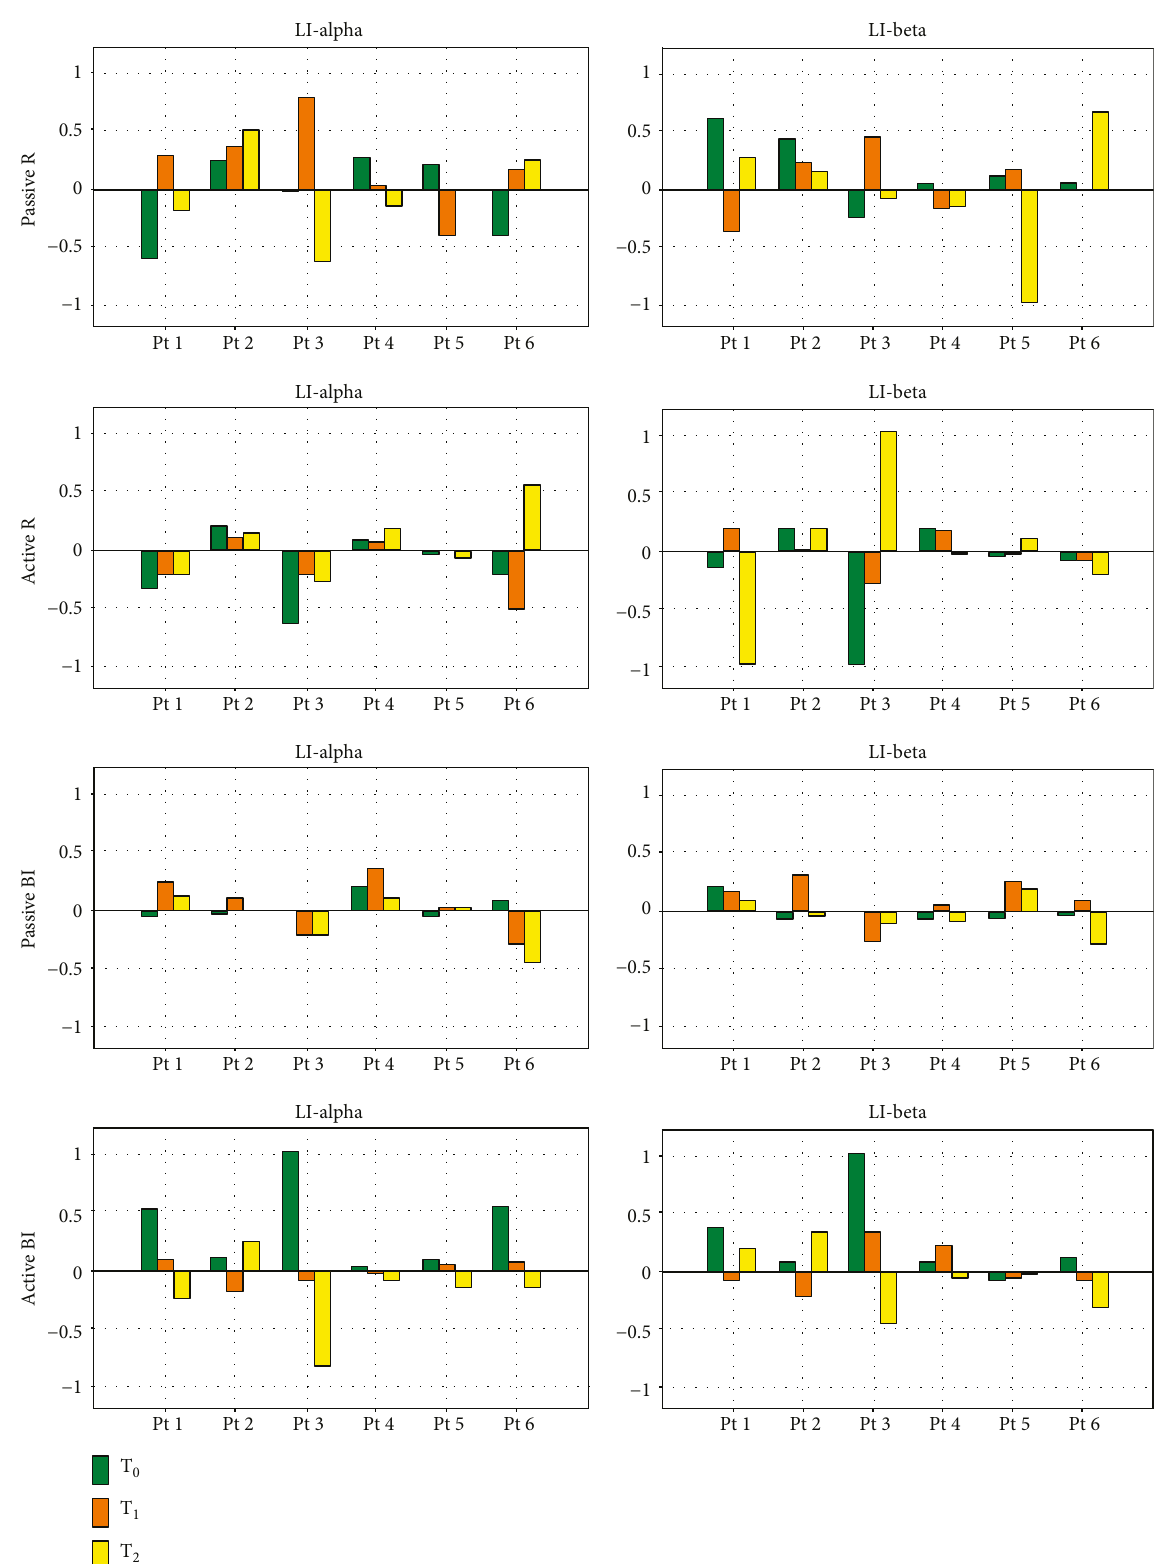
Figure 4: Laterality index (LI) in alpha and beta bands at each evaluation time point (T contralateral (ipsilesional) ERD as the C3 ERD value over the left sensorimotor area and ipsilateral (contralesional) ERD as the C4 ERD over the right sensorimotor area. LI > 0 indicates contralateral ERD and LI < 0 indicates ipsilateral